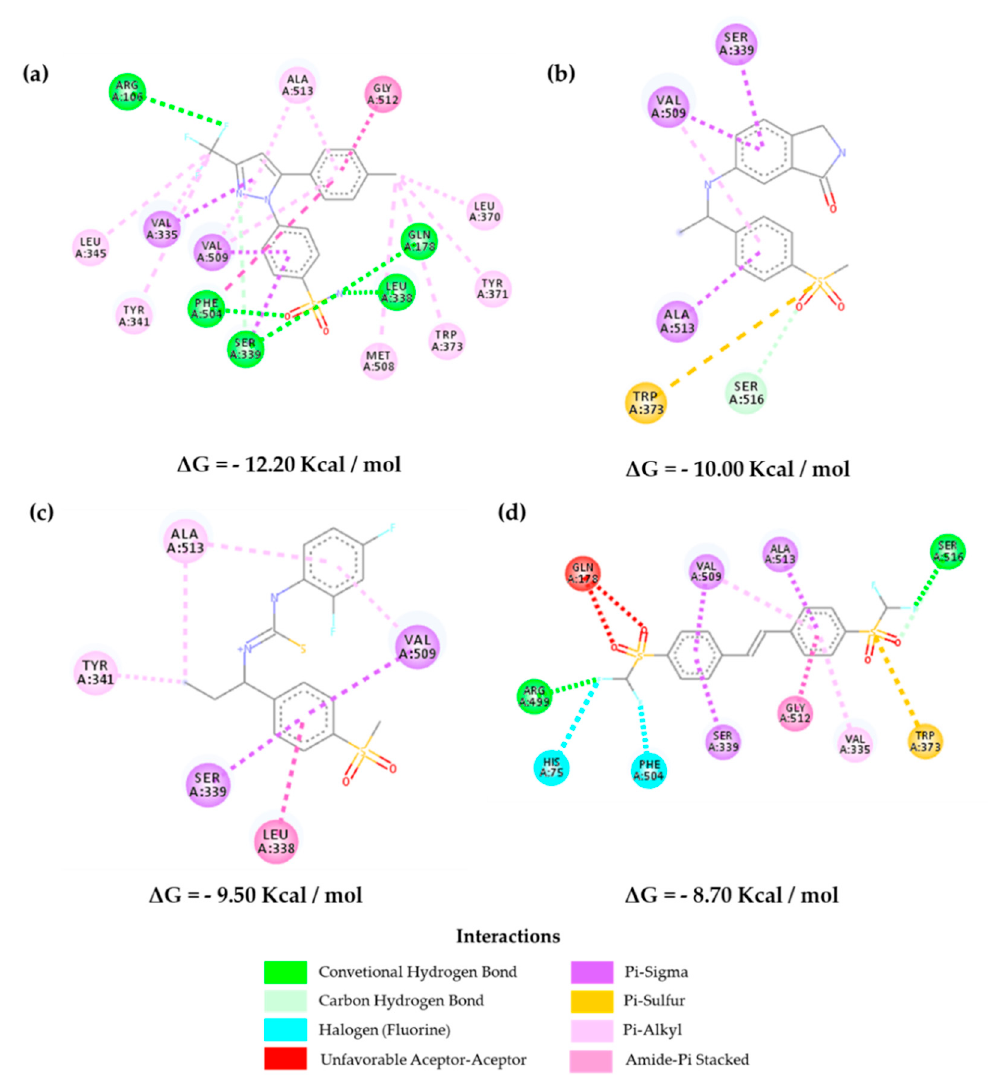
Figure 8. Interactions of inhibitors ( a ) celecoxib, ( b ) Z-627 , ( c ) Z-964 , and (d) Z-814 with the active site of the Mus musculus COX-2 (PDB 3LN1) .